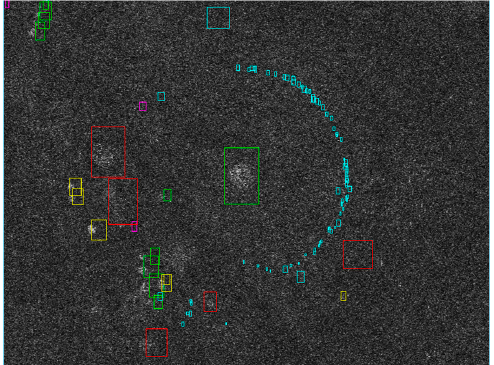
Figure 4. Saka kurgans and a non-archaeological structure (marked with the yellow arrow) in the TSX ST image from 16 September 2015 (SAR image © DLR, 2015). ( Saka kurgans = red, Scythian kurgans = green, ogradkas = purple, undatable mounds = yellow, and all other objects = cyan).